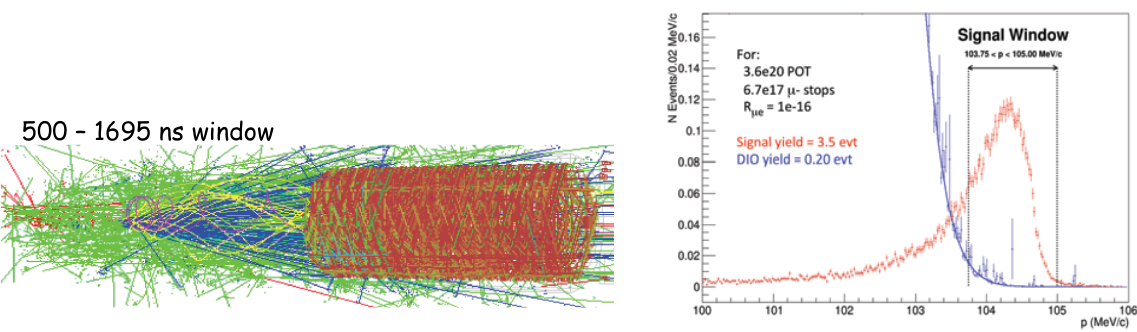
Figure 7. (Left) event display of a single micro-bunch event. (Right) full simulation of DIO and CE events for an assumed R μ e of 10 − 16 .